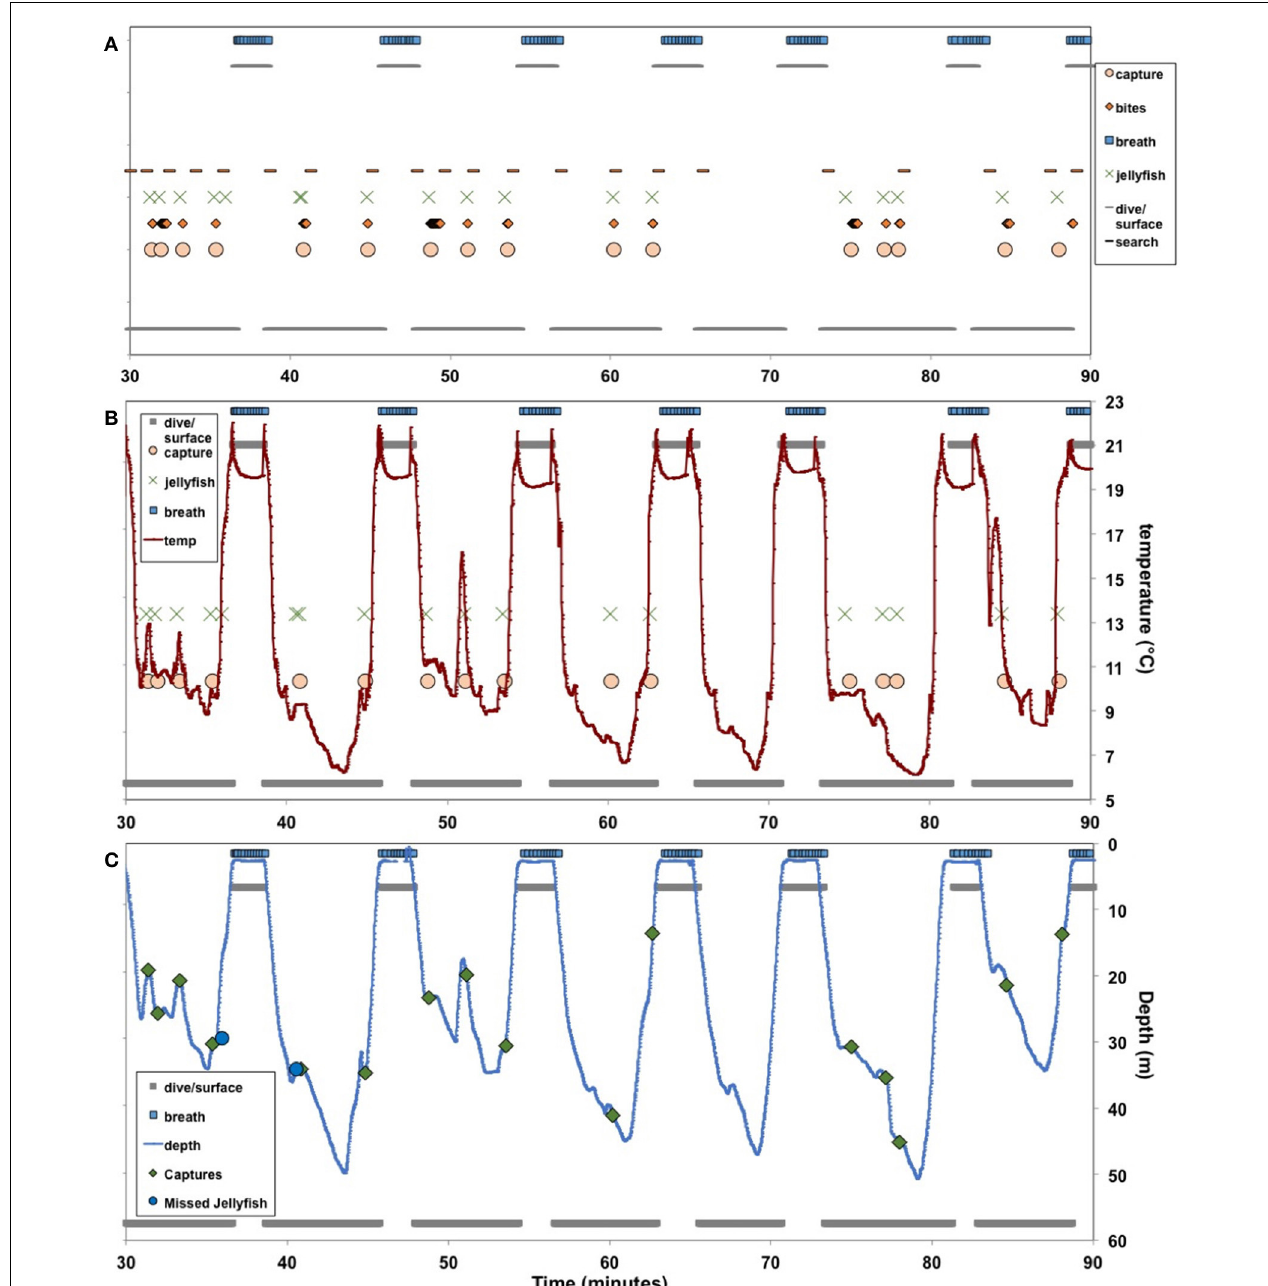
FIGURE 3 | Ethograms of leatherback turtles ( Dermochelys coriacea ) foraging in the Northwest Atlantic Ocean off Nova Scotia, Canada. Behaviors were documented from video footage obtained using turtle-borne video camera/time-depth recorders, coded using specialized computer software (Blumstein and Daniel, 2007), and durations and frequencies of different behaviors were quantified. Search, feeding, and breathing behaviors